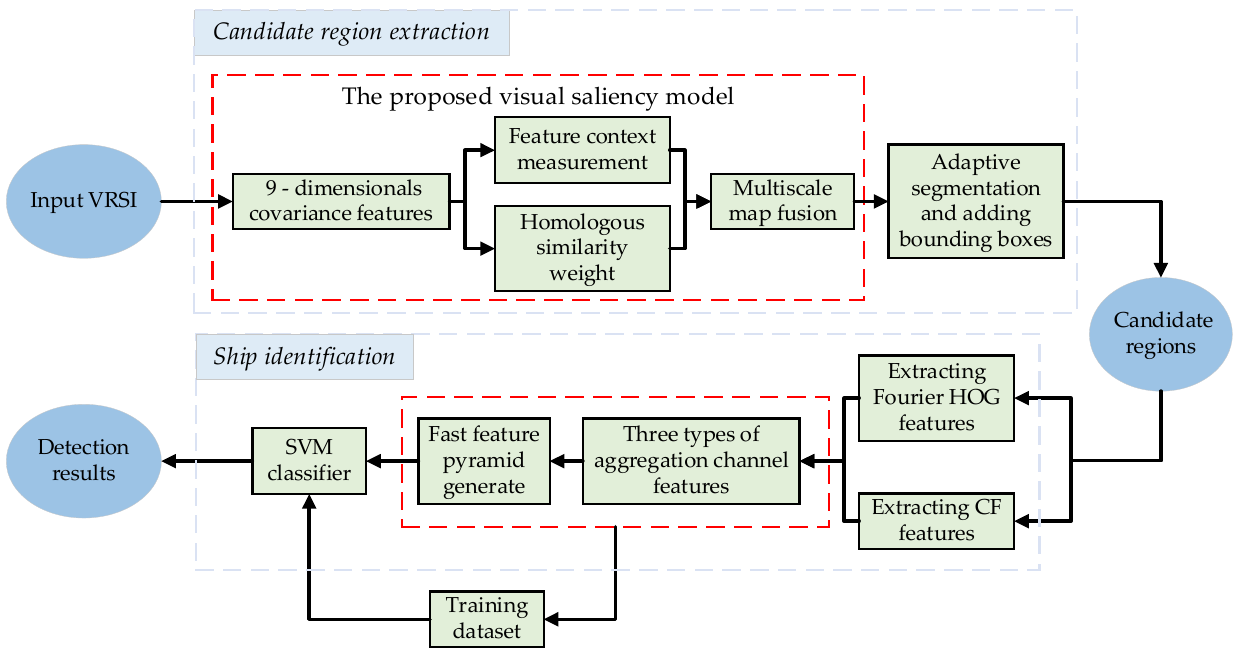
Figure 1. The flowchart of the proposed ship detection scheme.